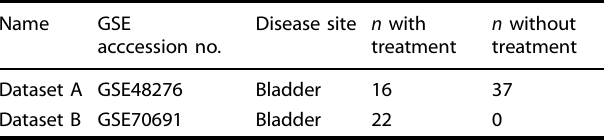
Table 3. Description of clinical datasets used for training and testing of CisSig-informed survival